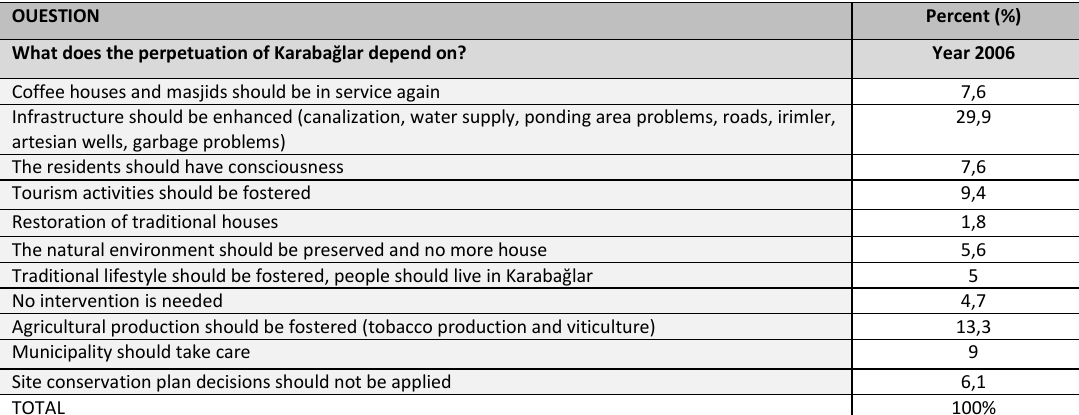
Table 7 Answers to the question: What should be done if the conservation plan does not preserve the area? QUESTION Percent